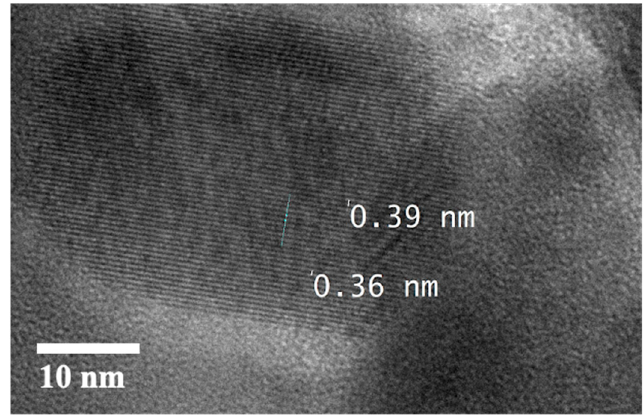
Figure 5. TEM image of a hexagonal CuS.